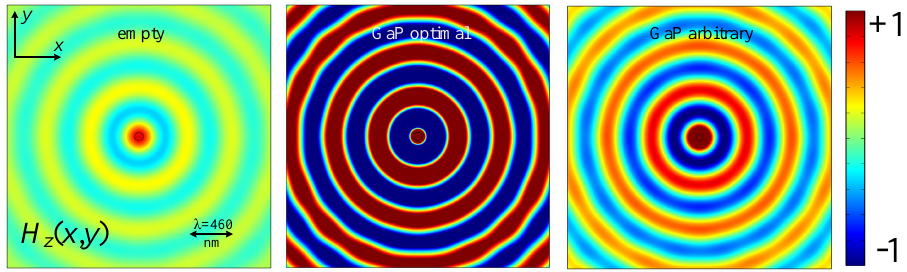
Figure 5. Spatial distribution of the normalized magnetic field H z ( z , y ) for: free space ( left ), optimal GaP cladding ( center ), and arbitrary, but close to optimal GaP cladding ( right ). The optimal design corresponds to the point of Figure 3b’s curve at λ = 460 nm. Design parameters: a / b = 0.01, b / λ =